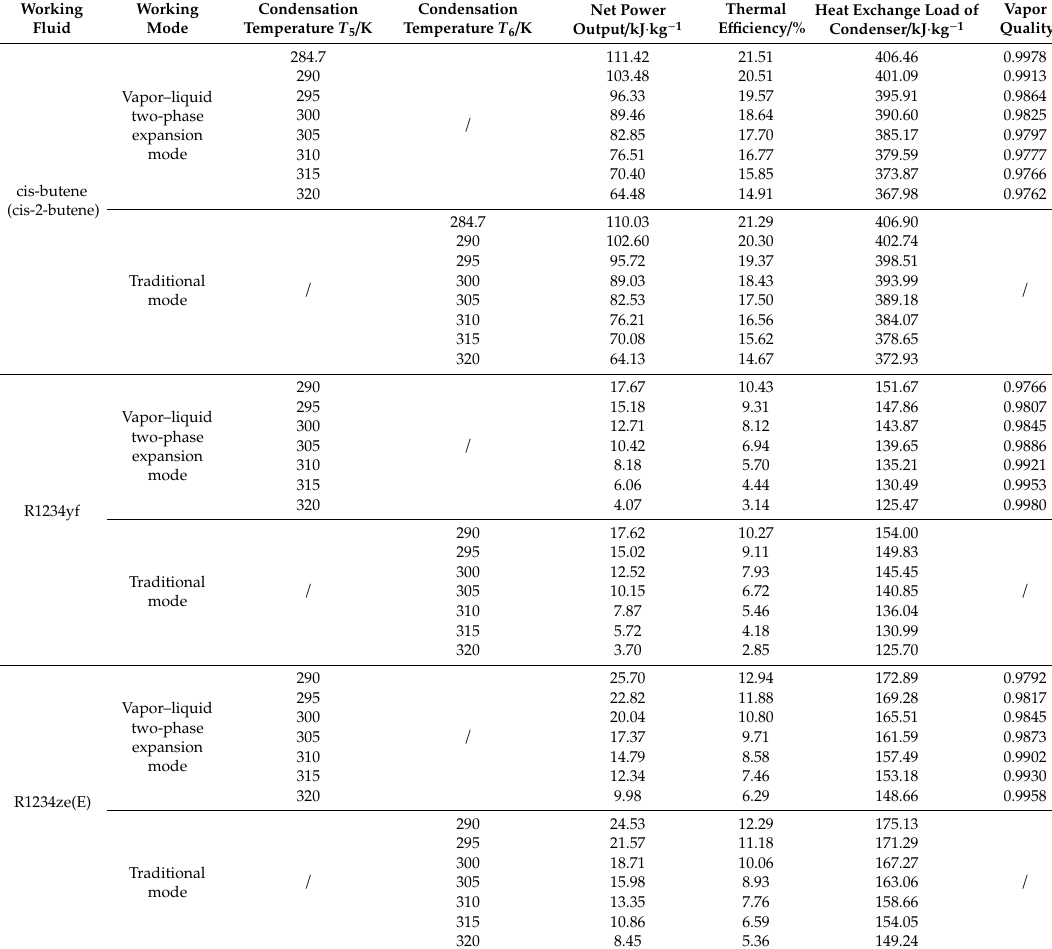
Table 3. Thermodynamic performance of the three working fluids in the subcritical cycle model when the condensation temperature is